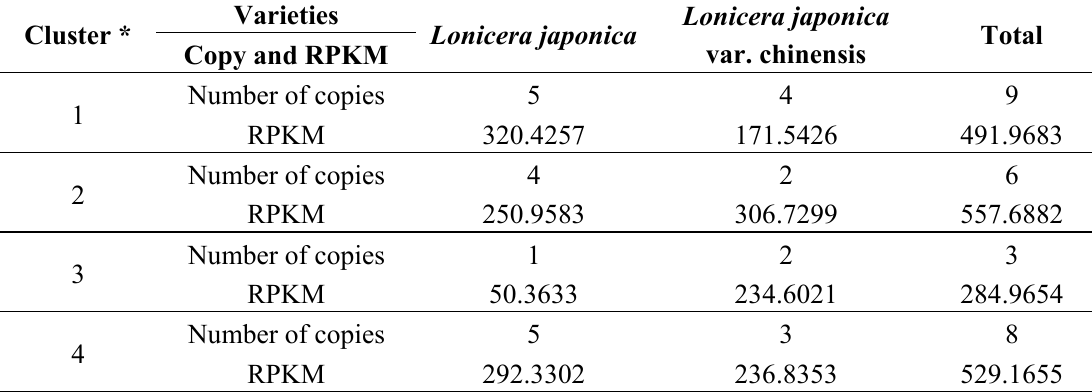
Table 3. Copy and RPKM of contained GEICIRG protein in Lonicera japonica . Cluster *